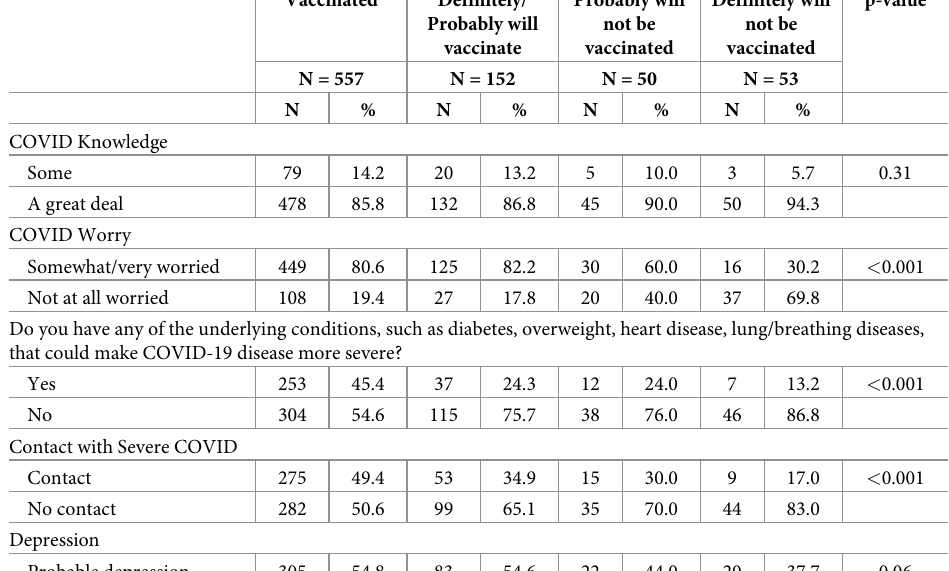
Table 7. Selected COVID-19 experiences and vulnerabilities by vaccine intentions, Wave 2, N =